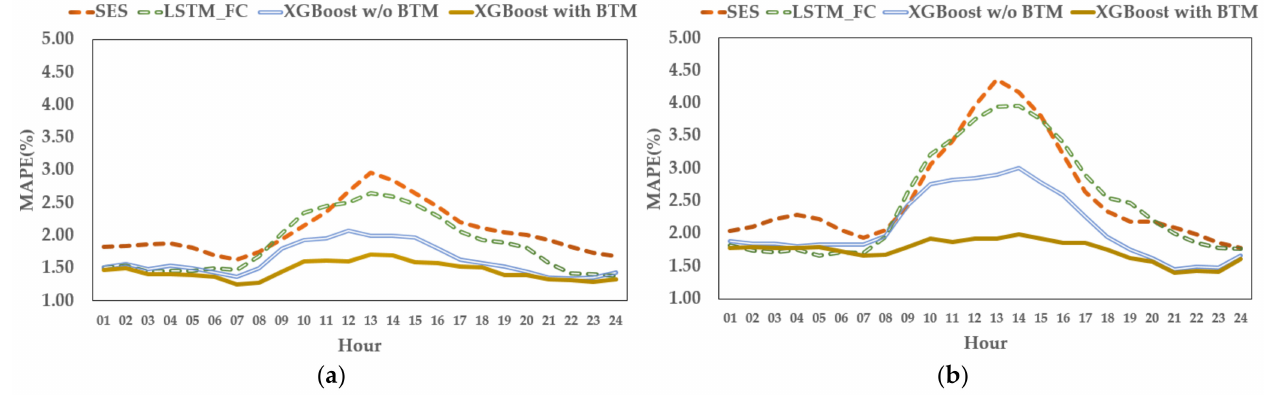
Figure 13. The hourly MAPE of the forecasting methods by year: ( a ) 2019; ( b )